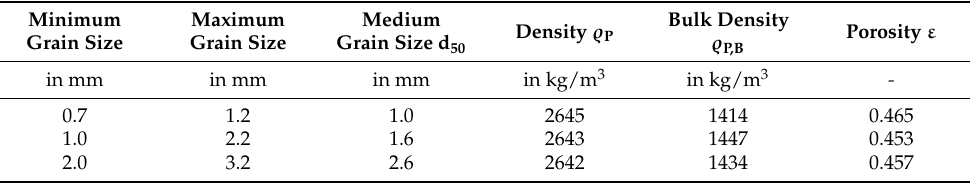
Table 2. Material properties of the used